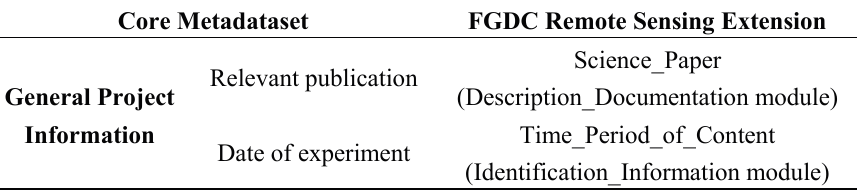
Table A6. Mappings from FGDC Content Standard for Digital Geospatial Metadata (Remote Sensing Extension) to the Core Metadataset.